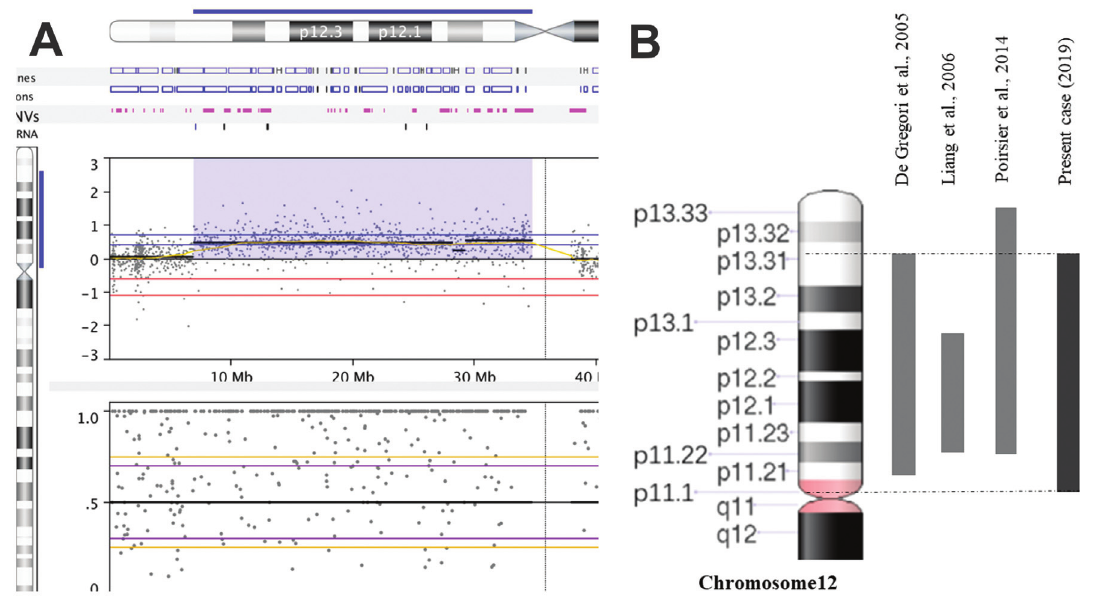
Figure 3 - Chromosome 12 characterization. (A) Array-CGH of chromosome 12, the color blue indicates the duplicated chromosomal region 12p13.31 (cid:2) p11.1 of ~28 Mb in size. (B) Duplication 12p patients reported in the literature with chromosome region similar to that of the present